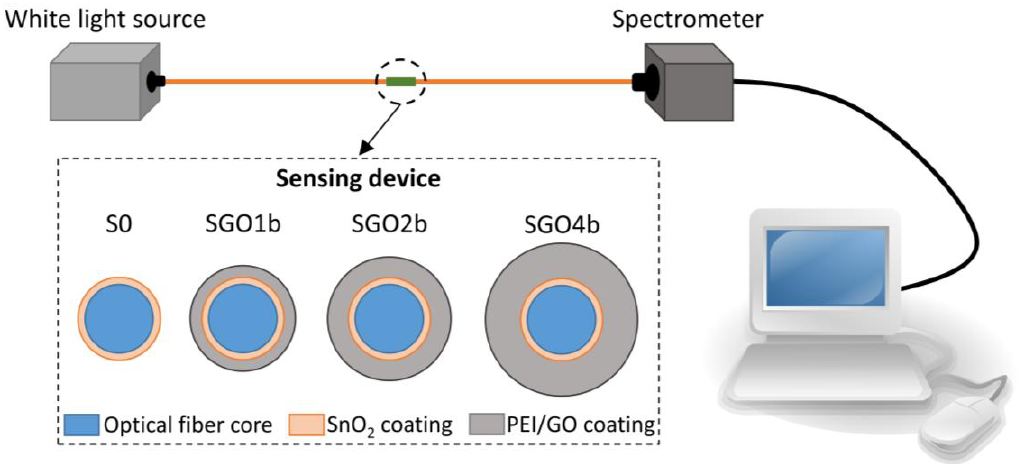
Figure 1. Optical fiber experimental setup and sensors schematic structure.